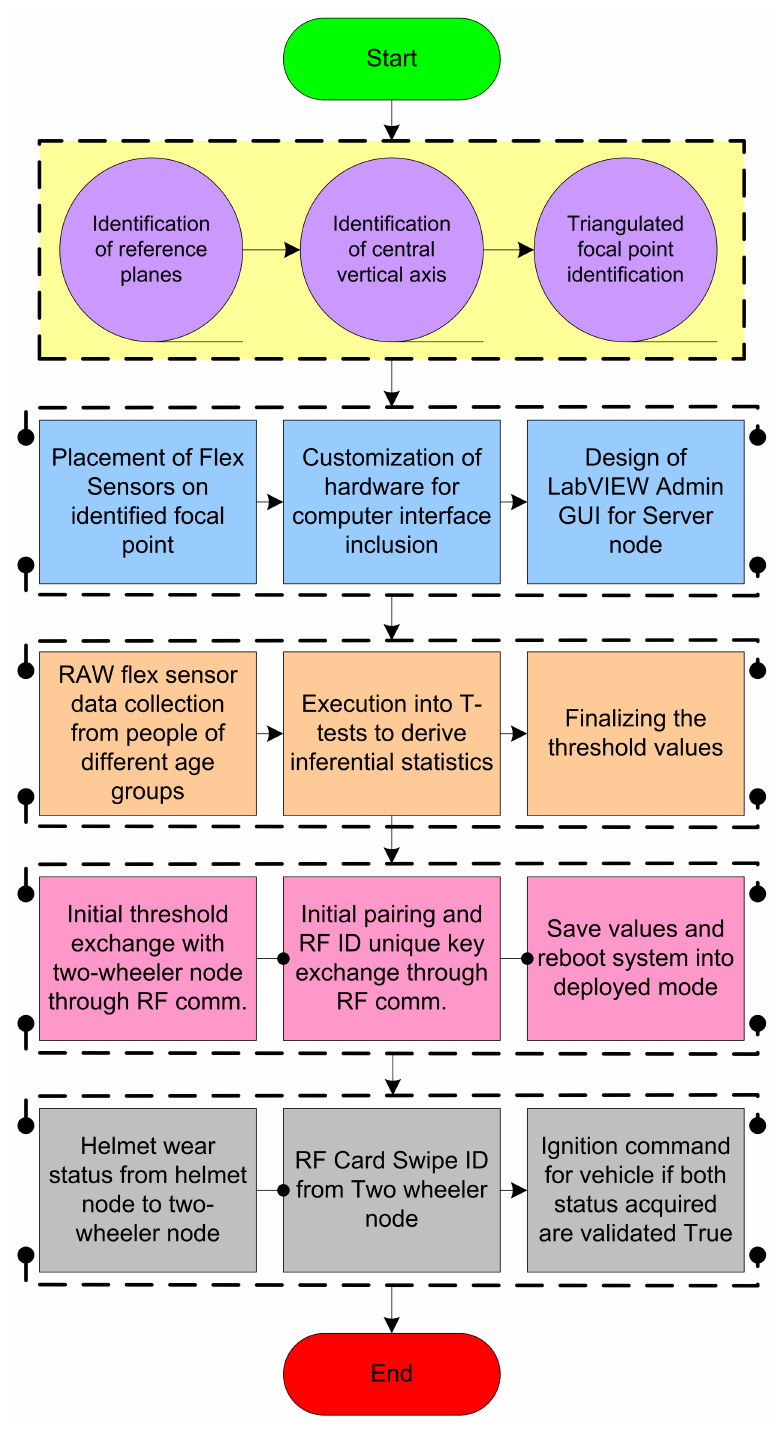
Figure 5. Methodology for the experimental